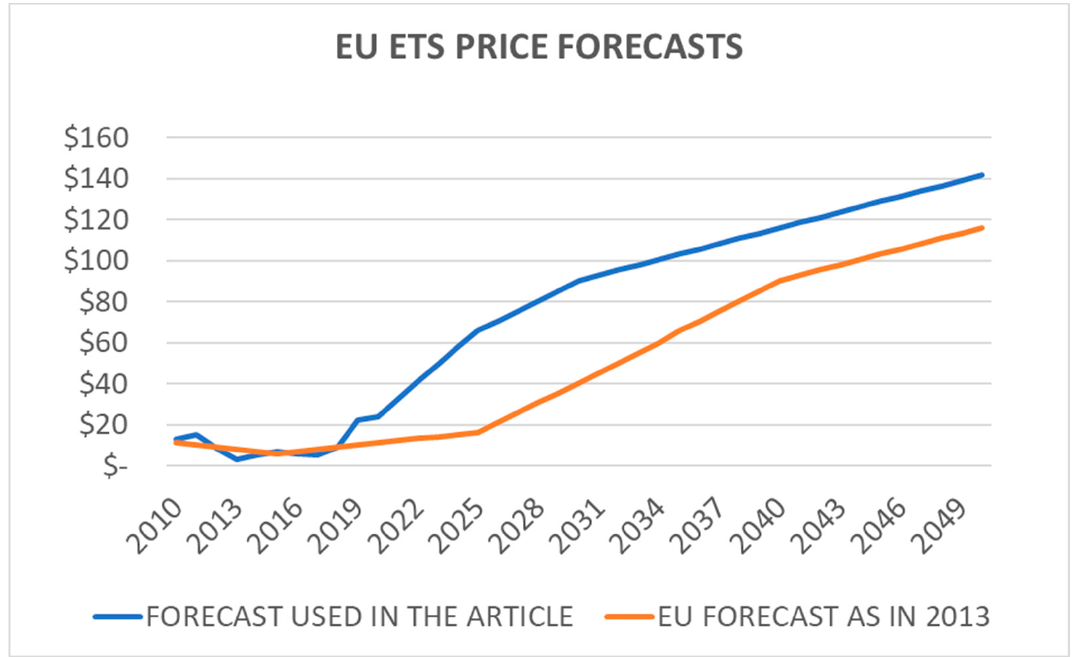
Figure 3. Projection of the ETS price from “EU Energy, Transport and GHG emissions: Trends to 2050” publication compared with the new forecast.